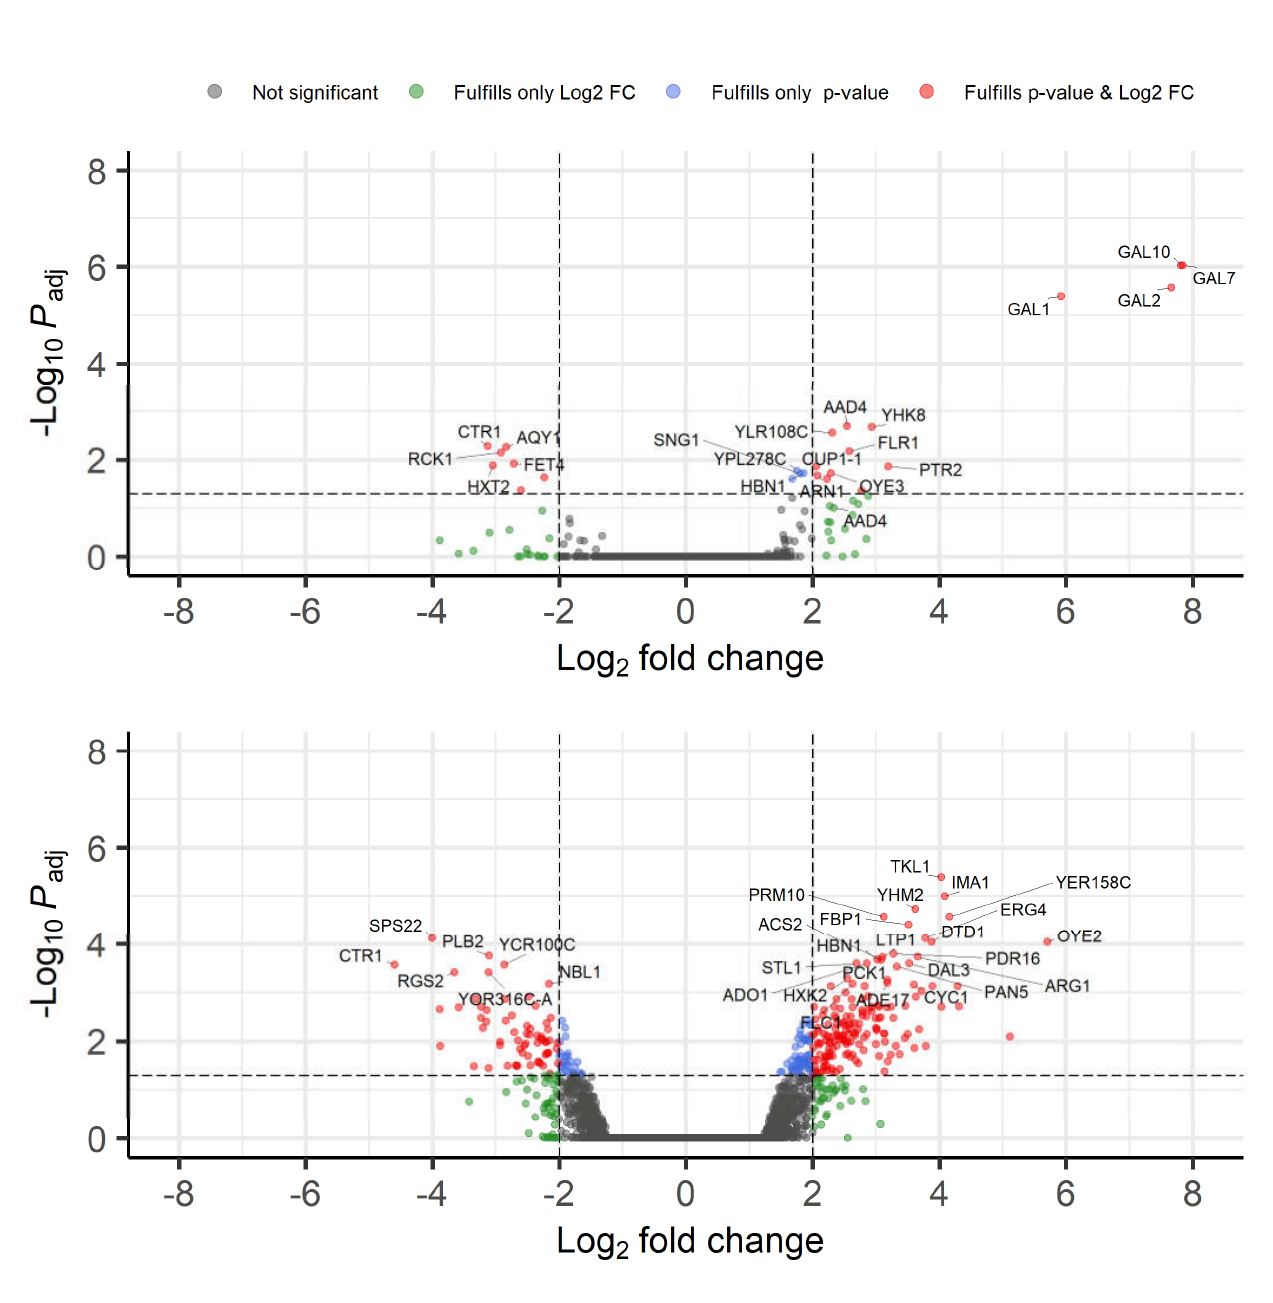
Figure 6. Volcano plots showing the results of the microarray data processed using the “global” settings of Limma’s decideTests. The P adj of the y -axis represents Benjamini–Hochberg adjusted p -values. ( Top ): Comparison of gene expression between spruce hydrolysate 9 h and sugar medium 9 h (SH 9 h vs. SM 9 h). Due to display limitations, only the 20 significant differentially expressed (DE) genes with lowest adjusted p -values from this comparison are labeled. Note that there are two probes on the Affymetrix Yeast Genome 2.0 array annotated as AAD4 and that only one of them (1771716_s_at) was found to be significantly DE by the test. Four genes with an average log 2 fold change just below the >|2| threshold were found to be statistically significant according to decideTests when the replicates were taken into consideration. ( Bottom ): Comparison of gene expression between spruce hydrolysate 17 h and sugar medium 17 h (SH 17 h vs. SM 17 h). The 30 significant differentially expressed (DE) genes with lowest adjusted p -values from this comparison are labeled. For this figure, all S. pombe and control probes were omitted, and thus only contain the 5814 S. cerevisiae probes from the Yeast Genome 2.0 array. The full results for all probes can be found in Supplemental Information